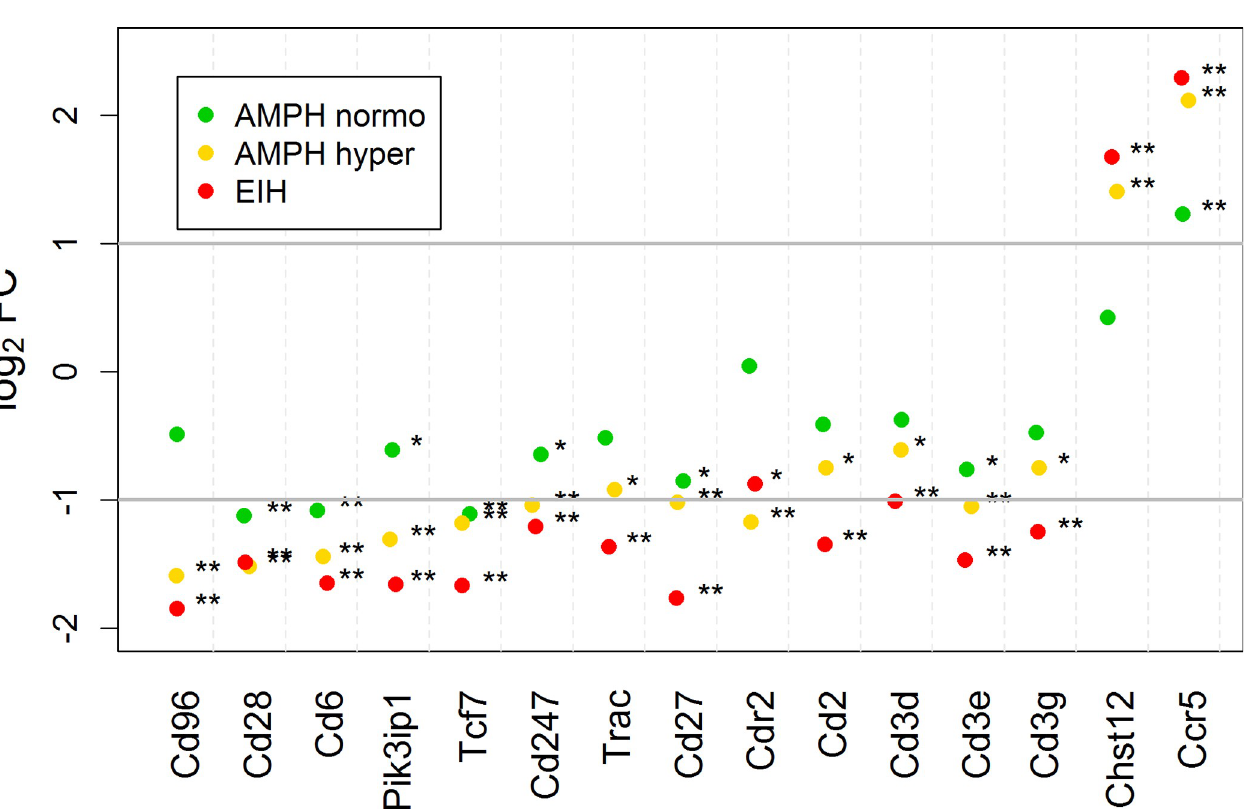
Fig 4. Scatterplot of fold-change expression for T-cell-specific mRNA transcripts in the whole blood. The log2 fold-change for the AMPH normo, AMPH hyper, and EIH groups relative to control are shown. The horizontal gray bars indicate a 2-fold increase and decrease in expression compared to control. The subscripts � and �� indicate that the fold-change is significant and exceeds 1.5 and 2,